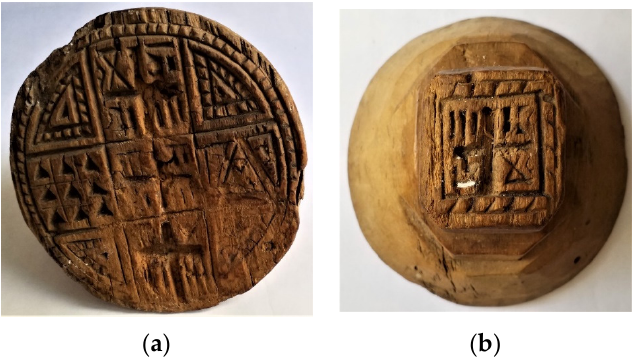
Figure 5. Olive wood stamp for the Offering Bread ( a , b : double-sided) used only at the exchange of greetings for the feast of Holy Easter in the Catholic community of Villa Badessa (Rosciano, Pescara, Italy) of the Greek-Byzantine rite [35]. Handmade and preserved on the wall of the Permanent Historical-Ethnoanthropological Exhibition of Villa Badessa (Rosciano, Pescara, Italy).